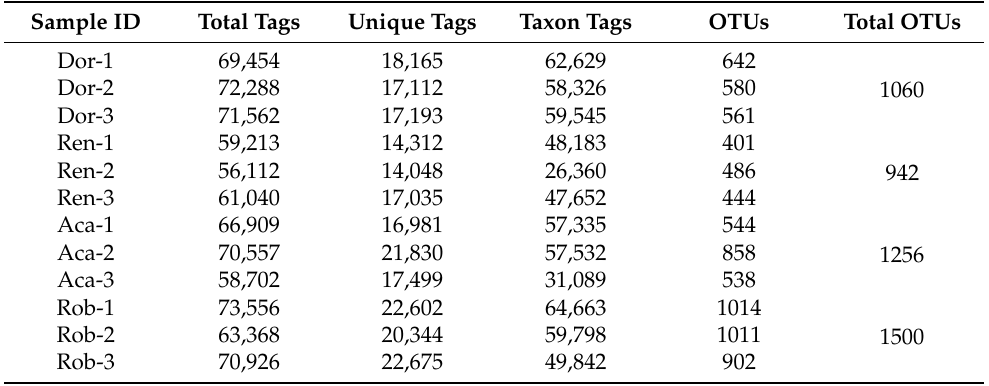
Table 1. All tags and operational taxonomic units (OTUs) in the roots of four wild orchid